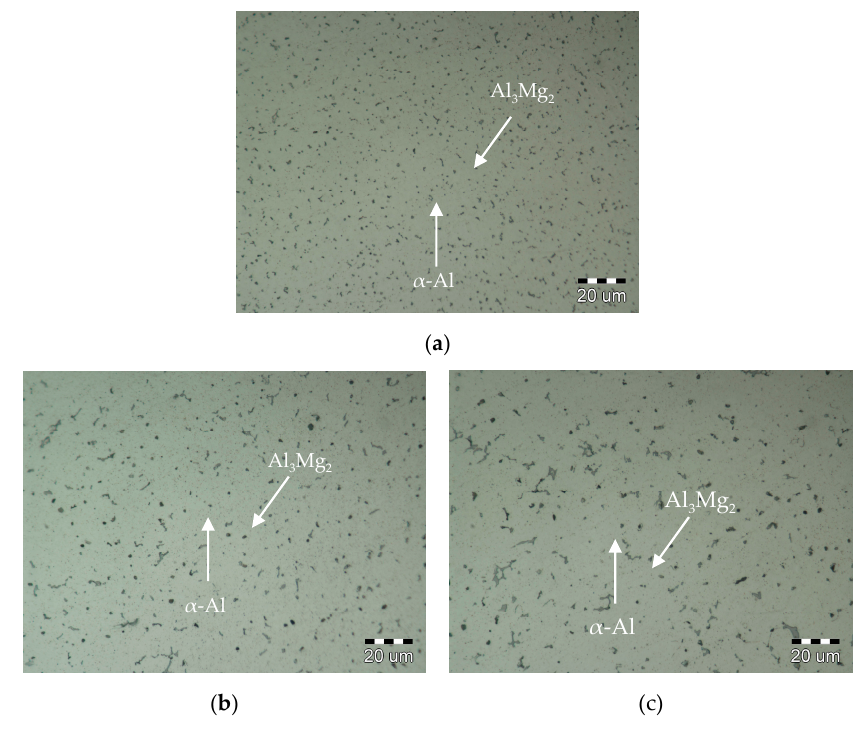
Figure 12. Microstructure of ( a ) the weld center from laser welding; ( b ) the weld center from 3.5 kA electric current aided laser welding; ( c ) the weld center from 5.0 kA electric current aided laser welding.